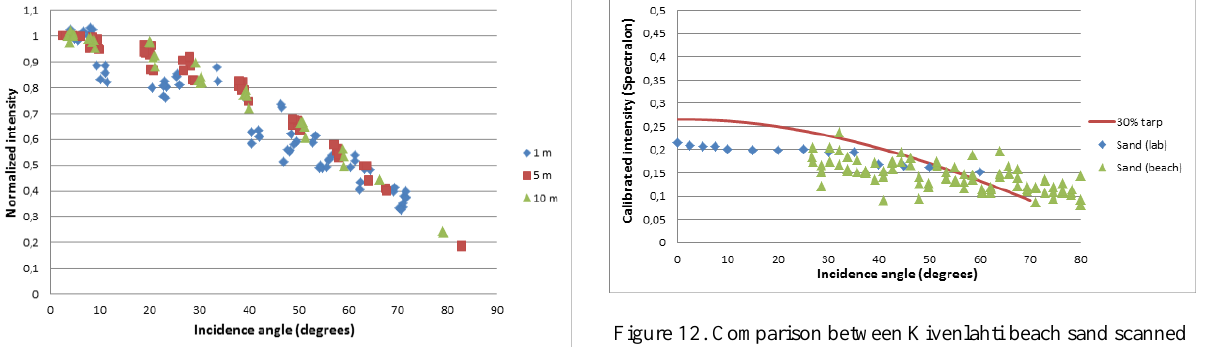
Figure 12. Comparison between Kivenlahti beach sand